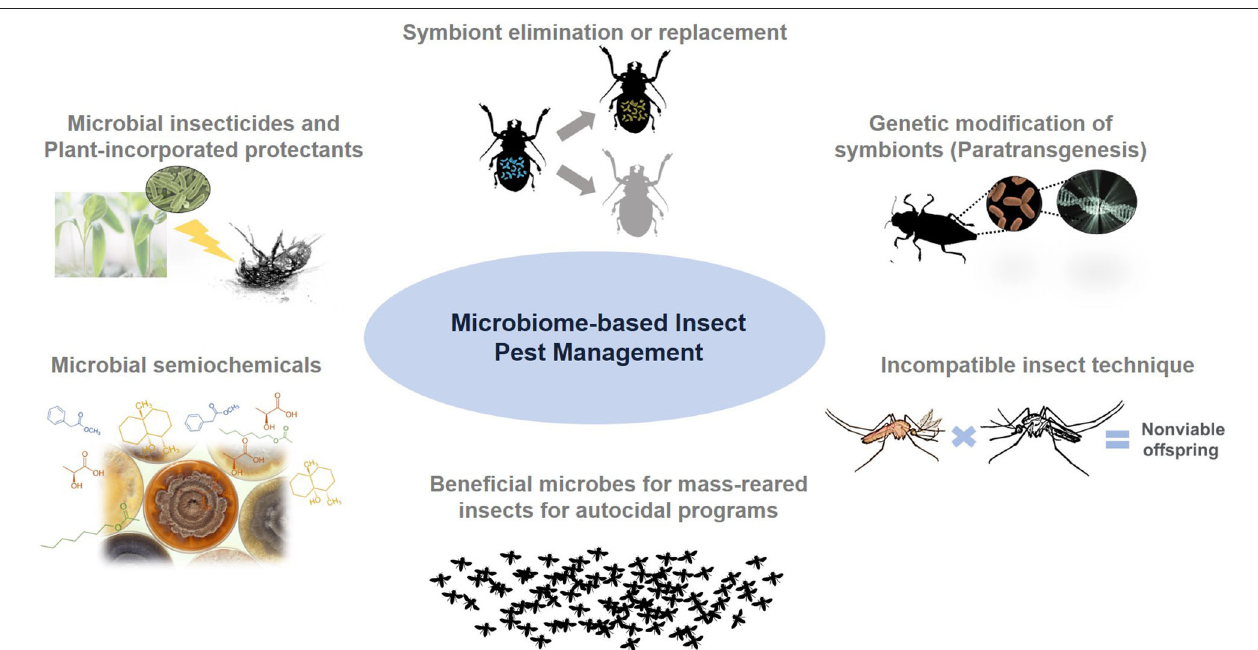
FIGURE 1 | Microbiome-based insect pest management approaches and